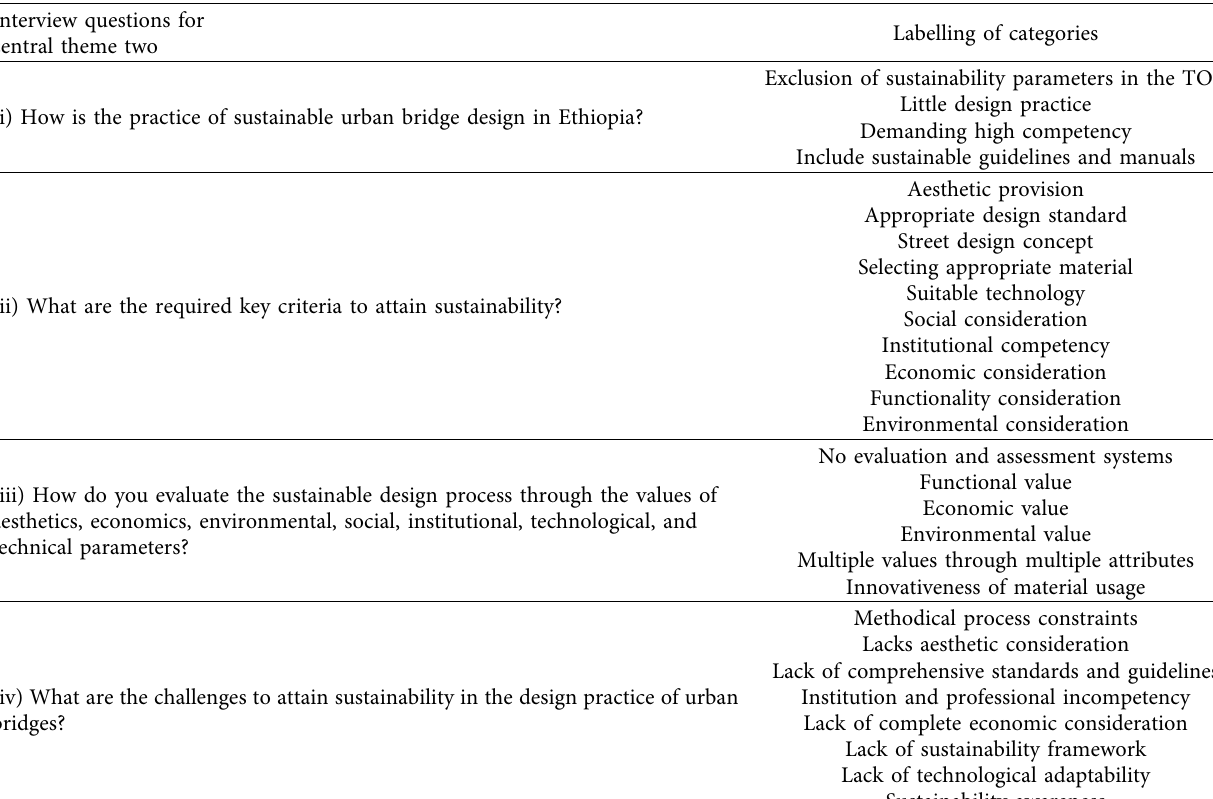
Table 4: Qualitative data analysis matrix for central theme